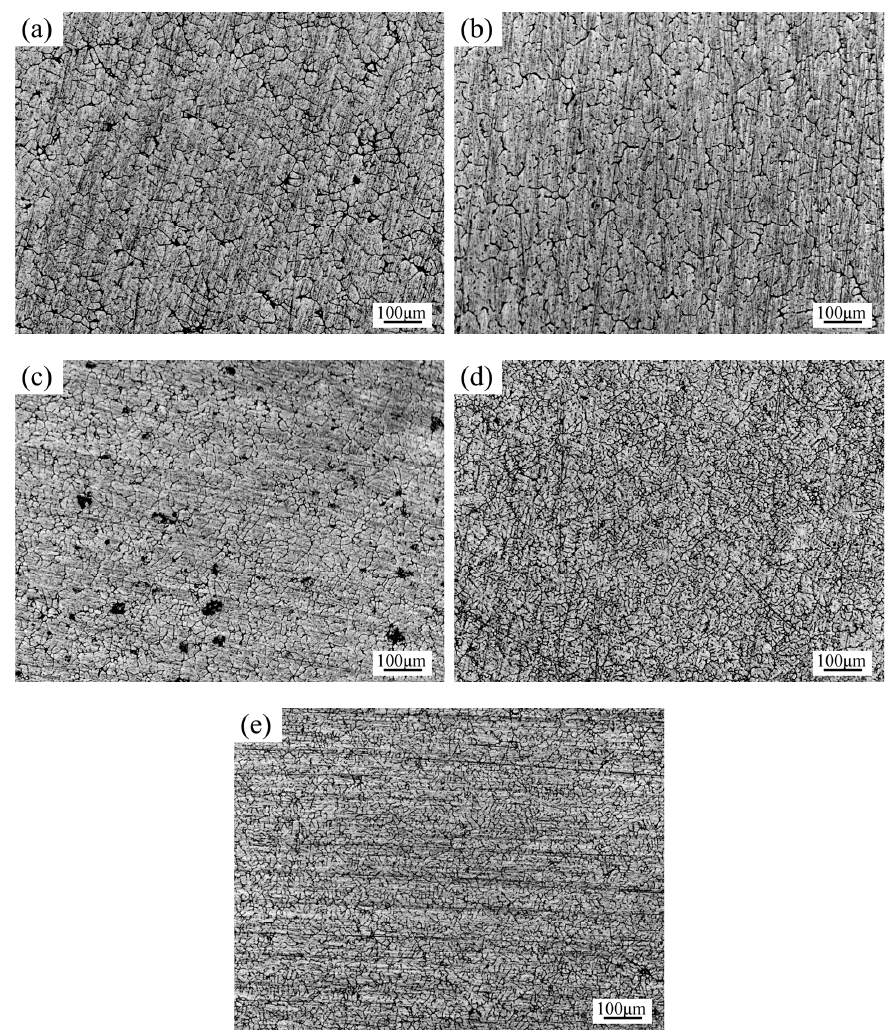
Figure 11. Metallographic photographs of the samples with different feeding distances: ( a ) 0 mm; ( b ) 1 mm; ( c ) 2 mm; ( d ) 3 mm; ( e ) 4